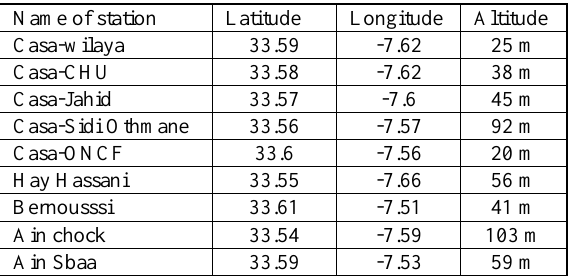
Table 1. Geographical references of the measuring station.